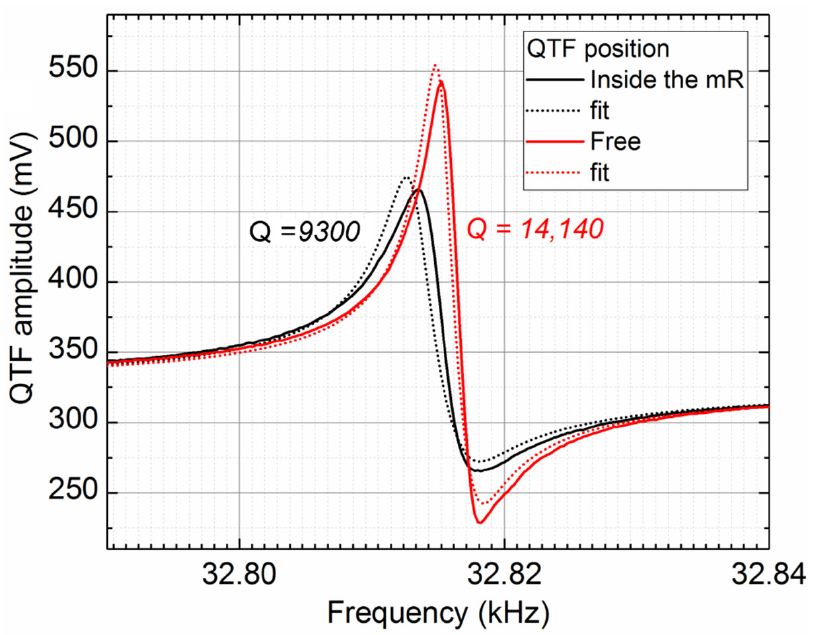
Figure 5. Frequency response of a QTF in free space ( red ) and positioned inside the double mR ( black ).